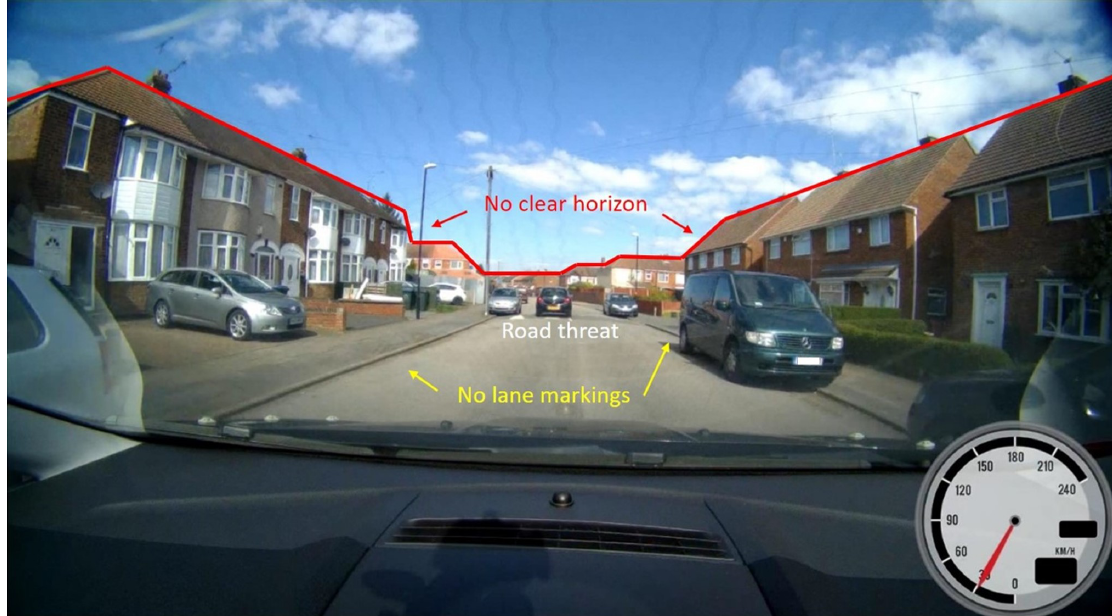
Figure 13. Corner case driving scenario including unclear horizon line, non-existing lane markings and obstructed road bump